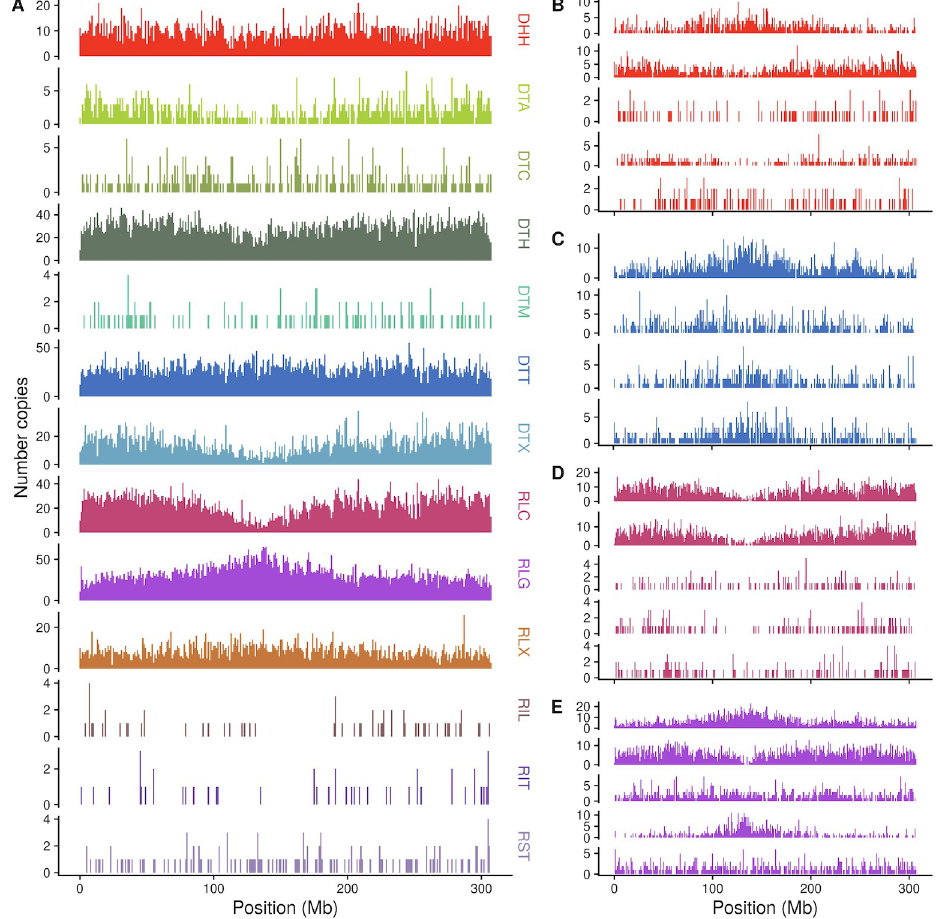
Fig 3. Chromosomal distribution of superfamilies and example families. Counts of number of insertions in 1 Mb bins across chromosome 1 for (A) TE superfamilies and (B-E) the 5 families with highest copy number in each of four superfamilies, DHH (B), DTT (C), RLC (D), and RLG (E). Family names are listed in S1 Table.